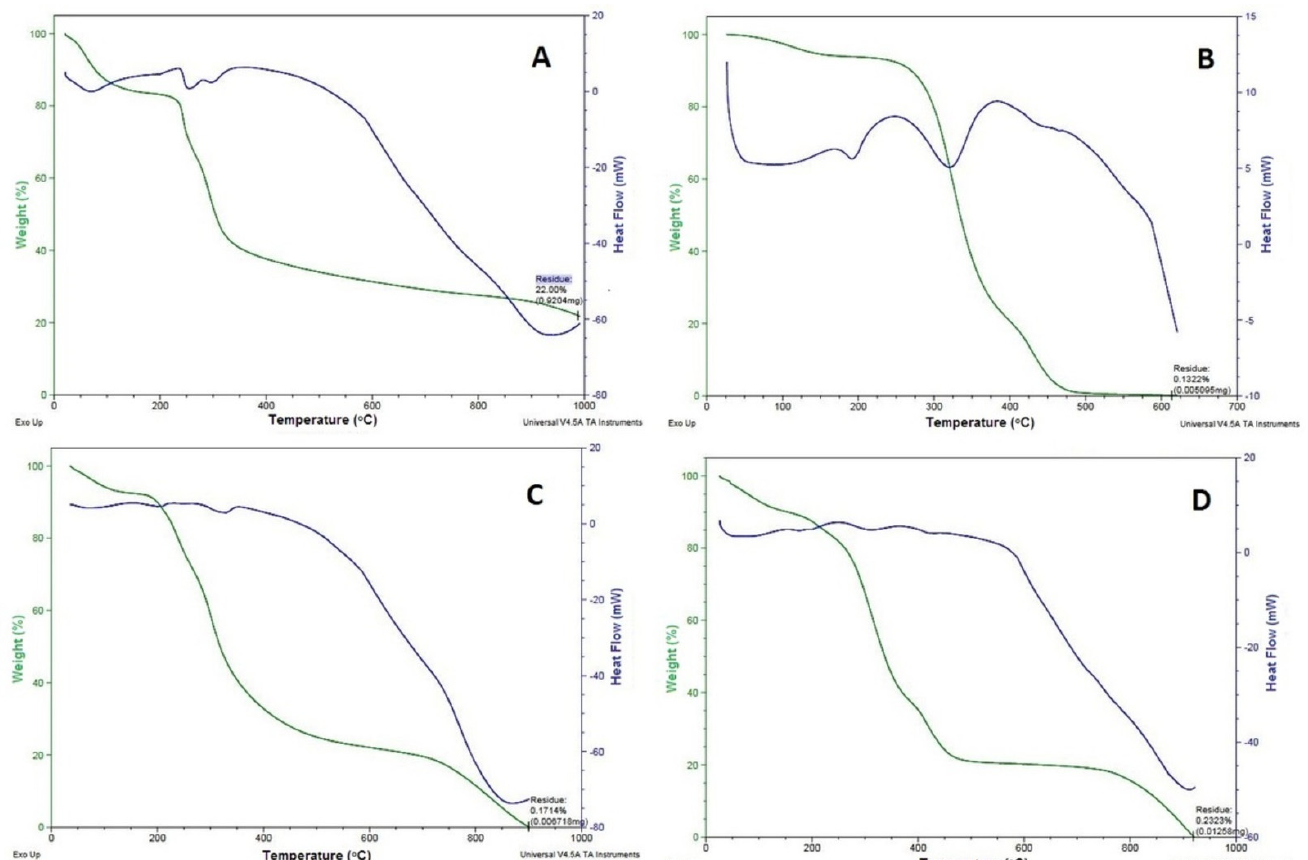
Figure 3. DSC (blue) and TGA (green) curves of ( A ) Keratin, ( B ) PVA, ( C ) GS, and ( D ) 1:4 composite scaffold.